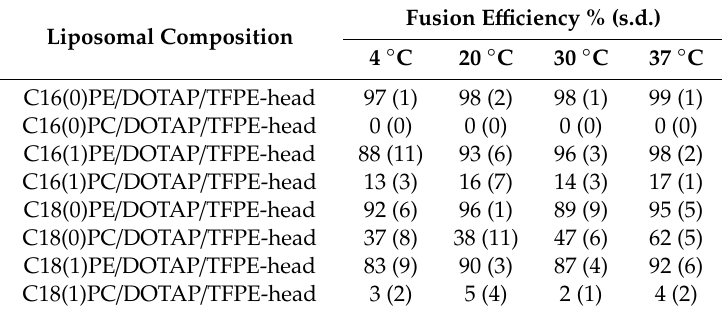
Table 2. Temperature dependence of fusion e ffi ciencies of liposomes containing the cationic lipid DOTAP, di ff erent neutral lipids, and TFPE-head as an aromatic molecule (1 / 1 / 0.1 mol / mol). Experiments are performed in a PBS bu ff er at physiological pH 7.4 and osmolality 280 mOsm / kg. Given are averages over at least three independent measurements and, in parentheses, their standard deviations.